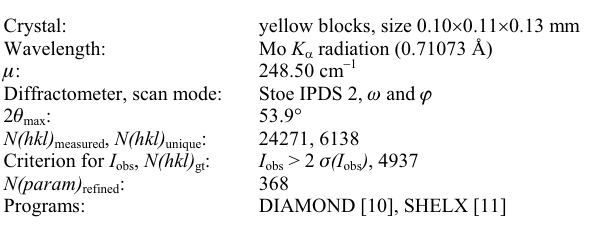
Table 1. Data collection and handling.